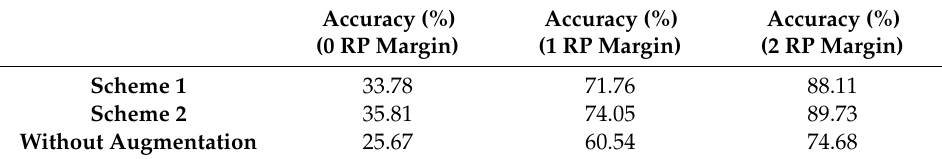
Figure 14. Cumulative distribution function curves comparing position accuracy using data augmentation and unaugmented data. Table 3. Experimental results for real-time positioning.